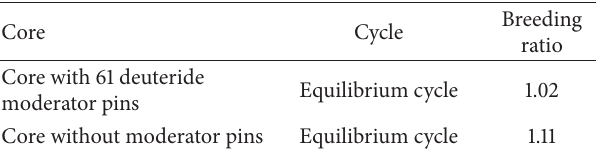
Table 4: Comparison of breeding ratio between cores with and without